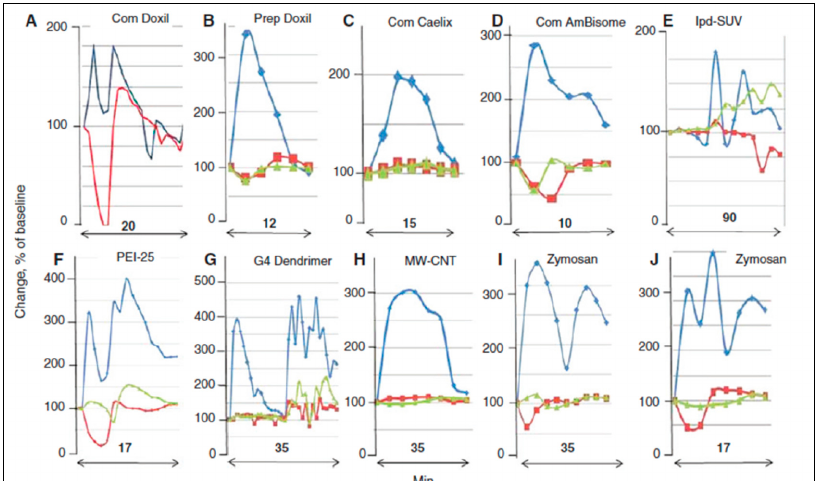
Figure 3. Variation of PAP and SAP waveforms. Panels ( A – J ) represent reactions to identical or different NPs, selected from different experiments, wherein the CARPAgenic potential of nanoparticulate drugs or drug carriers were tested in pigs. Minutes indicate the timespan of reactions. Blue, red, and green are PAP, SAP, and heart rate curves, respectively. Changes are shown in percent of baseline. Abbreviations (only here): com, commercial; prep, self-prepared; lpd, lipophilic prodrug-containing liposomes; PEI25, 25 kD pegylated poly(ethylene imine); G4 dendrimer, 4th generation dendrimer; MW-CNT,